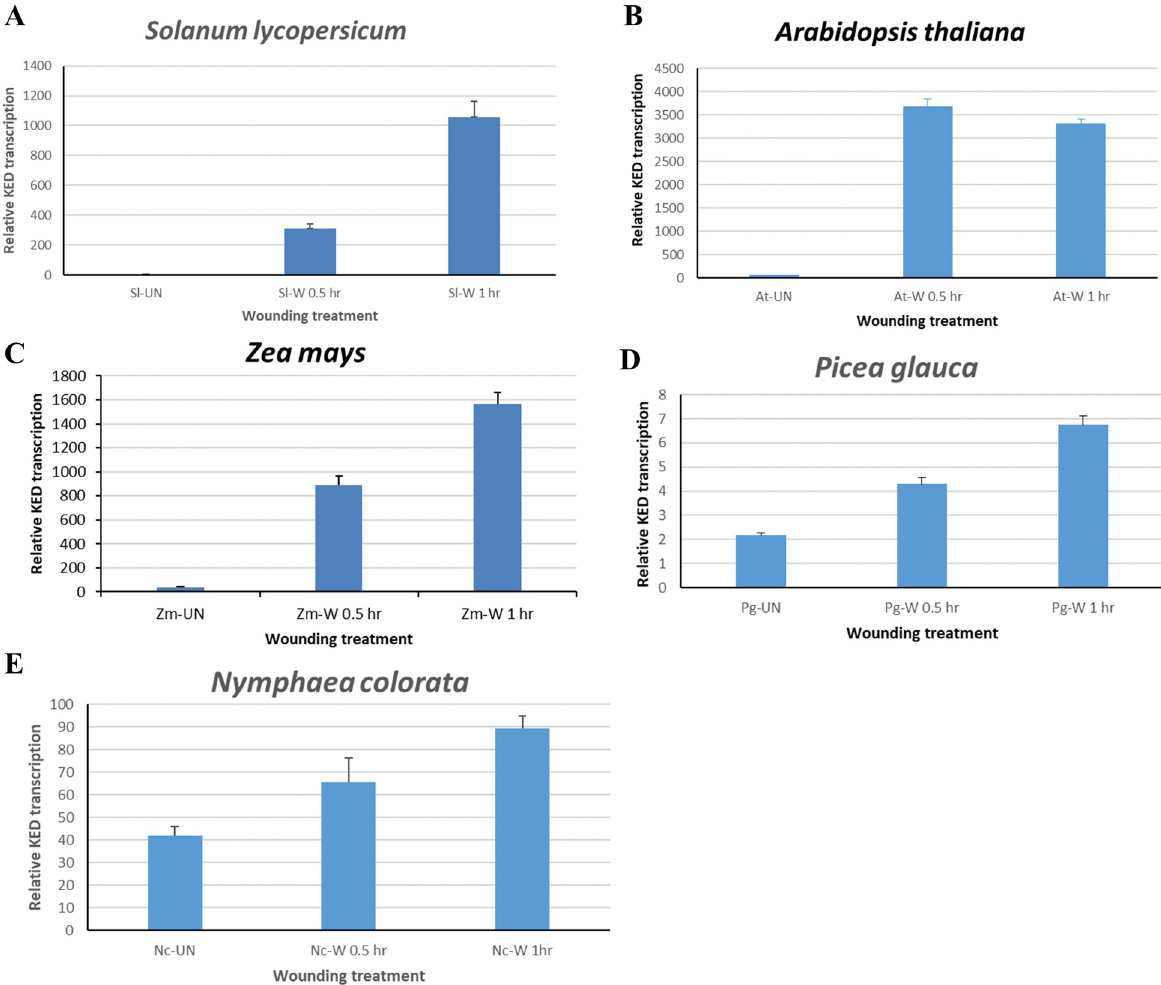
Fig 1. Wound-responsive transcription of KED genes in representative plants. A. Solanum lycopersicum (tomato; eudicot, angiosperm); B. Arabidopsis thaliana (eudicot, angiosperm); C. Zea mays (corn; monocot, angiosperm); D. Picea glauca (spruce; conifer, gymnosperm); E. Nymphaea colorata (waterlily; aquatic angiosperm). UN: un-wounded; W: wounded for 0.5 hour or 1 hour. Error bars denote standard deviations.